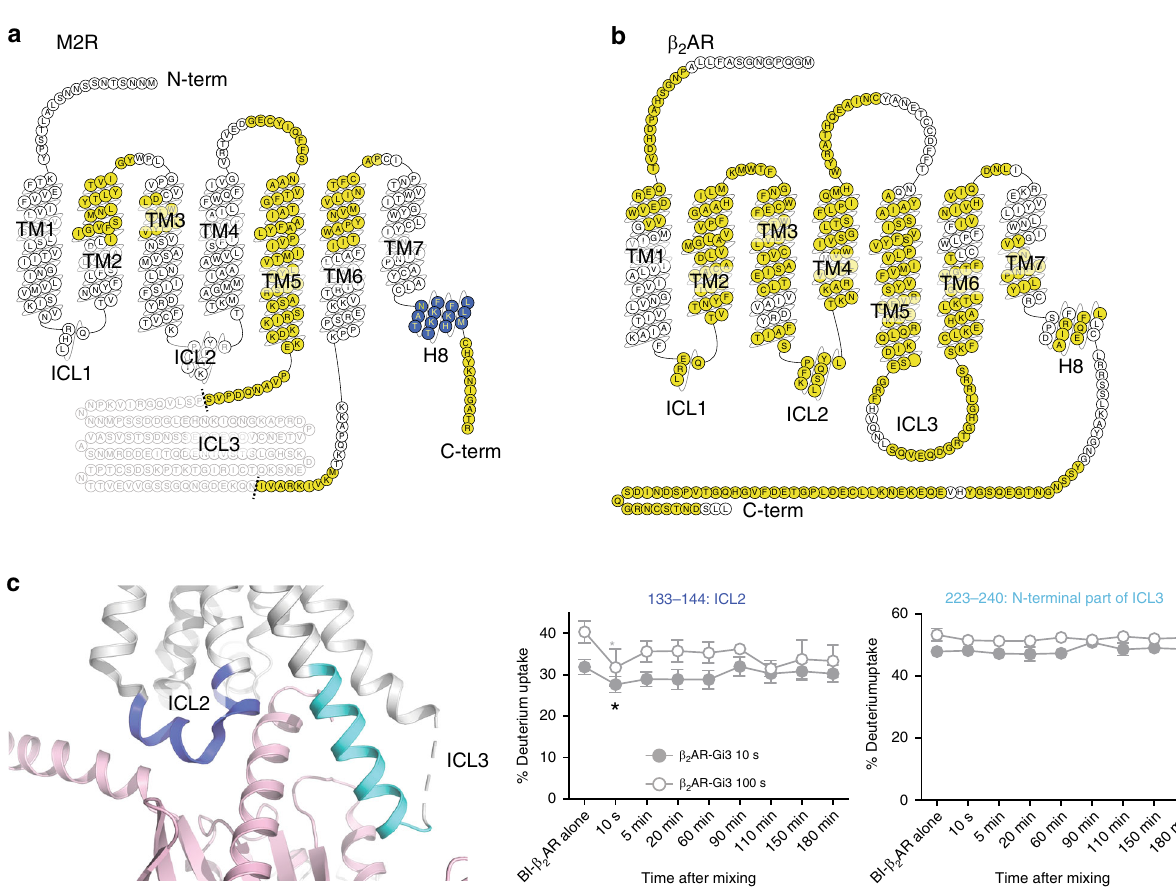
Fig. 4 HDX pro fi les of the receptors during M2R-GoA and β 2 AR-GoA coupling. a , b HDX level changes of the M2R ( a ) and the β 2 AR ( b ) after 3 h of incubation with GoA. The changes in HDX are color-coded on the snake maps from GPCRdb (gpcrdb.org). Gray residues in M2R indicate truncated ICL3 for better expression and puri fi cation. White residues indicate regions without identi fi ed peptides; yellow residues indicate regions without HDX changes; and blue residues indicate regions with decreased HDX upon co-incubation with GoA. c Pulsed HDX-MS analysis of selected peptides of the β 2 AR during β β 2 AR-Gi/o coupling. The selected peptides analyzed are color-coded on the X-ray crystal structure of 2 AR (PDB 3SN6) and on the titles of the deuterium uptake graphs. Light pink color represents G α s. Statistically signi fi cant changes during coupling were analyzed by repeated-measures ANOVA (rANOVA). To compare two different time points, a two-tailed paired Student ’ s t -test was performed, and p < 0.05 was considered as statistically signi fi cant. * Indicates the fi rst time point that showed a statistical difference compared with pre-incubation. Error bars represent mean ± S.E.M of three independent experiments. Please note that the data is plotted using a non-linear/non-logarithmic